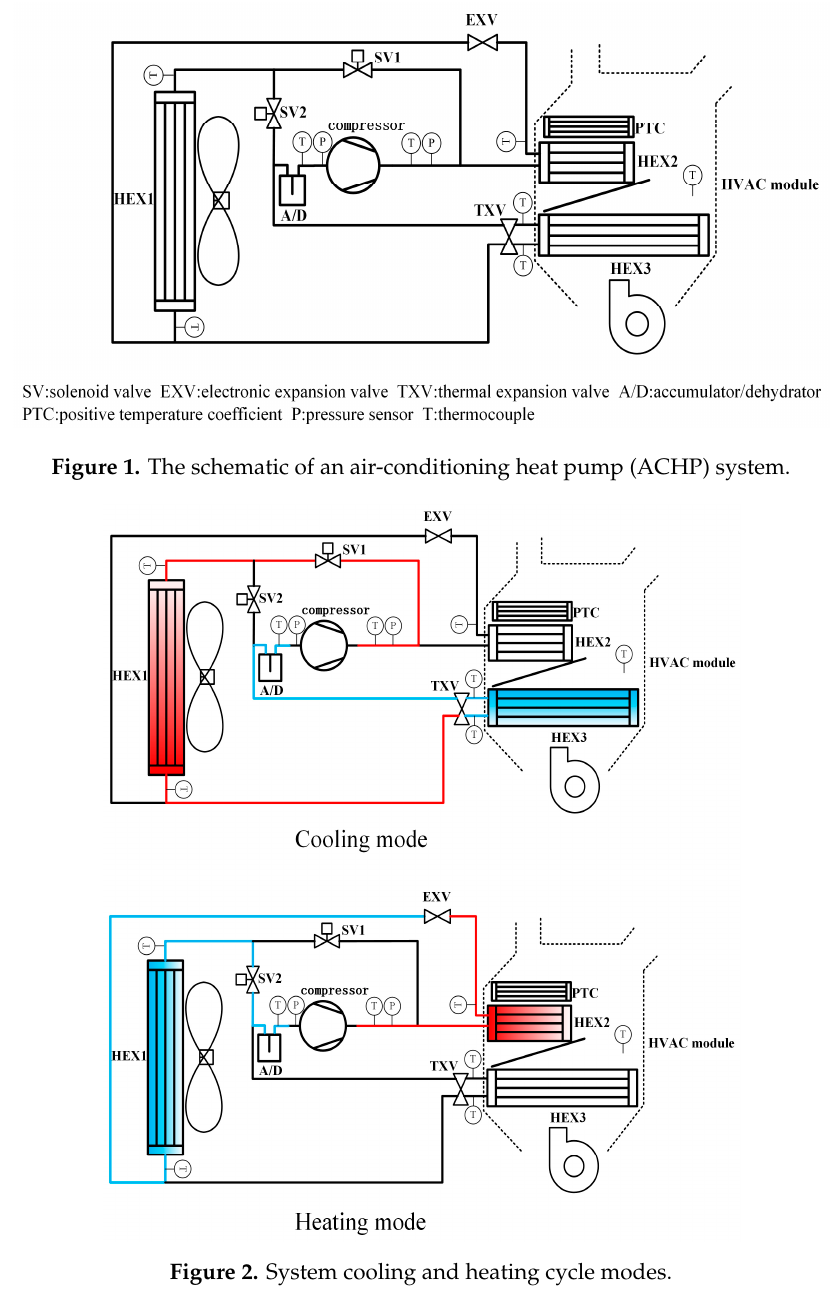
Figure 2. System cooling and heating cycle modes.